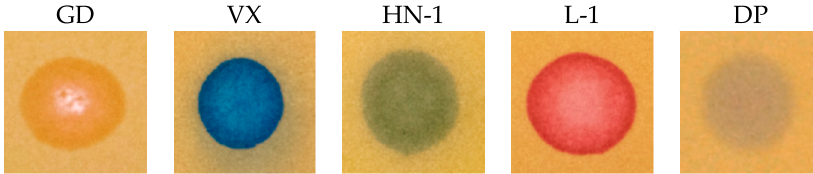
Figure 8. Color stability of detection papers during storage at a temperature of 80 °C (tristimulus colorimetric measurement of the surface color change).